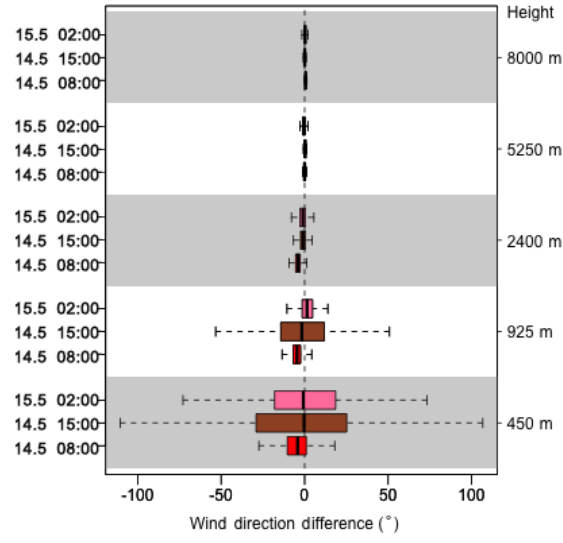
Figure 18. Wind direction differences between HR and HR_RESHIFT in domain 2.